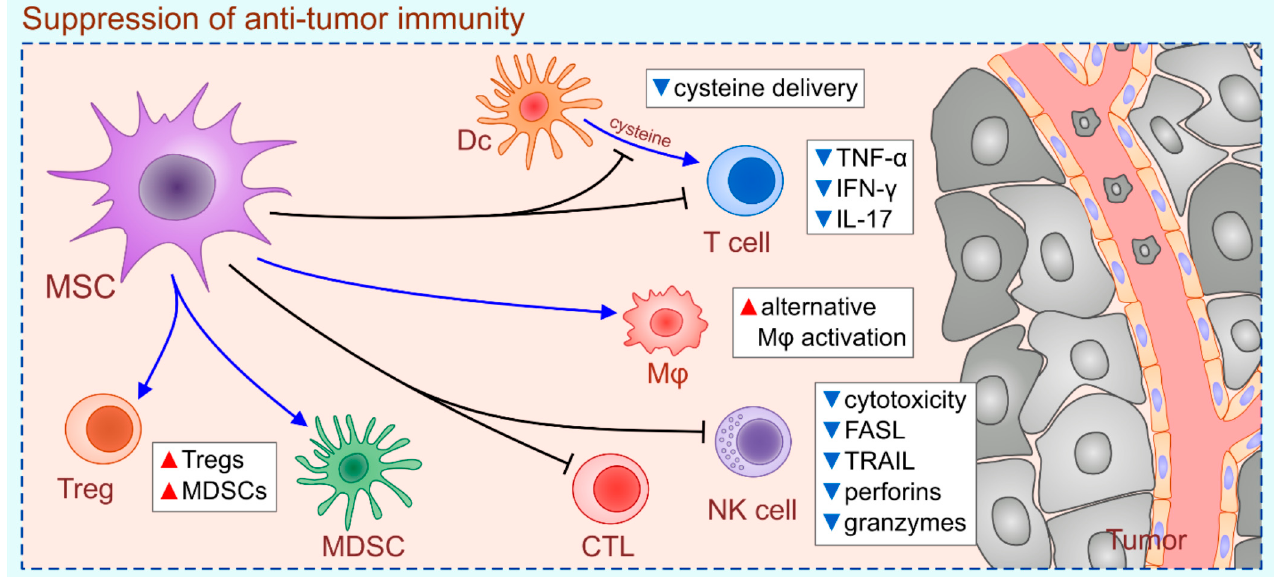
Figure 1. MSC-based suppression of anti-tumor immunity. MSCs promote tumor growth by: (i) preventing DC-based cysteine delivery to T cells, (ii) inducing alternative activation of tumor-associated macrophages, (iii) suppressing production of TNF- α , IFN- γ and IL-17 in CD4+T helper cells, (iv) inhibiting cytotoxicity of FASL on CTLs and NK cells (down-regulated expression of FASL and TRAIL; reduced secretion of perforins and granzymes) and (v) promoting generation and expansion of Tregs and MDSCs. The red triangles represent increased number of cells and their products; the blue triangles represent the decreased number of cells and their products.